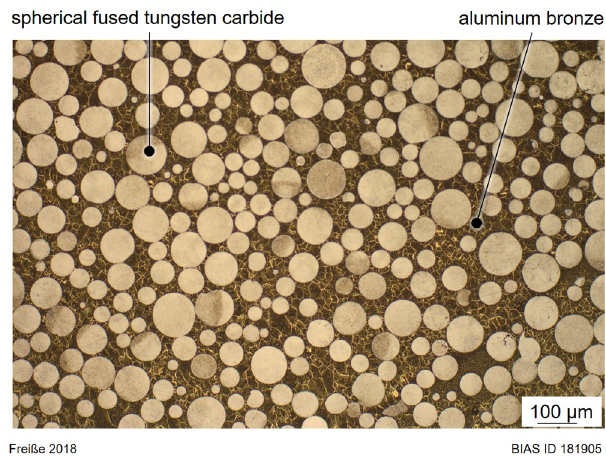
Fig. 10. Homogenous distribution of spherical fused tungsten carbide particles in aluminum bronze after laser melt injection.